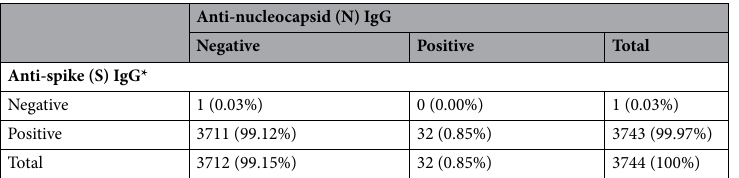
Table 2. Anti-Spike (S) IgG and anti-Nucleocapsid (N) IgG titers after 2 doses of mRNA-1273 or BNT162b2 COVID-19 vaccine in the general population (N = 3744). Anti-spike (S) IgG was measured using Vitros Anti– SARS-CoV-2 S1 Quant IgG (Ortho Clinical Diagnostics). Positive was defined as ≥ 17.8 binding antibody units/mL. Anti-nucleocapsid (N) IgG was measured using Elecsys Anti-SARS-CoV-2 (Roche Diagnostics